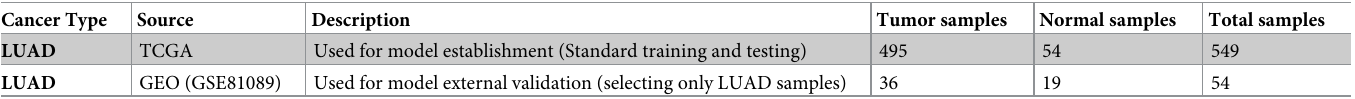
Table 4. A graphical overview of the data